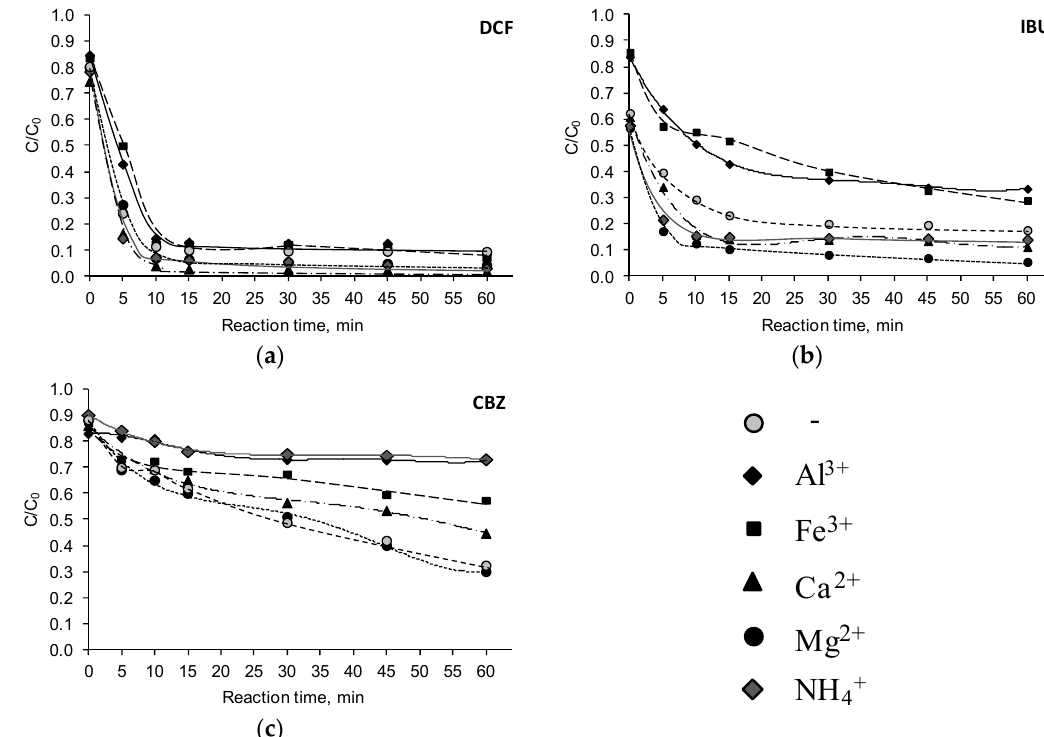
Figure 3. Influence of different cations on the photocatalytic degradation of pharmaceuticals ( a ) DCF; ( b ) IBU and ( c ) CBZ present in water suspensions.